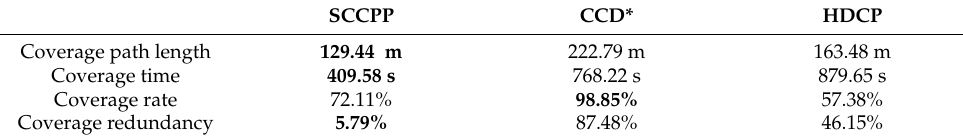
Table 2. Comparisons of the SCCPP, CCD* and HDCP algorithms for the Gallery scenario .